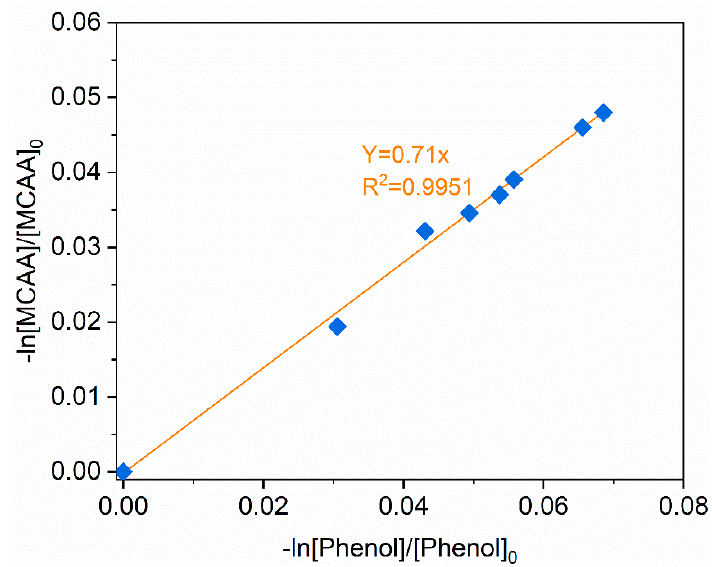
Figure A1. Linear fitting of -ln[MCAA]/[MCAA] 0 Vs -ln[Phenol]/[ Phenol] 0 . Conditions: dosing rate of iodide = 1.28 μ M ⋅ L − 1 (approximately equal to the iodide releasing rate of BiOI); [Phenol] 0 = 0.05 M; [S(IV)] 0 = 0.1 M; [MCAA] 0 = 10 μ M; N 2 O saturation; reaction time 10 min; pH = 7.0, 25 ± 1 °C.